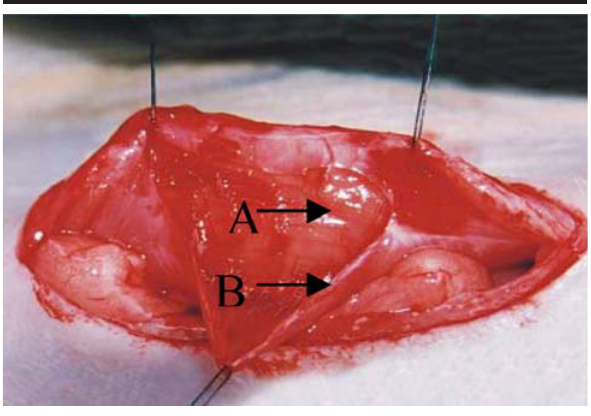
FIGURA 1 - Ilustração de laparotomia para retirada do espécime. A - músculo reto do abdome e B - peritônio-fáscia.